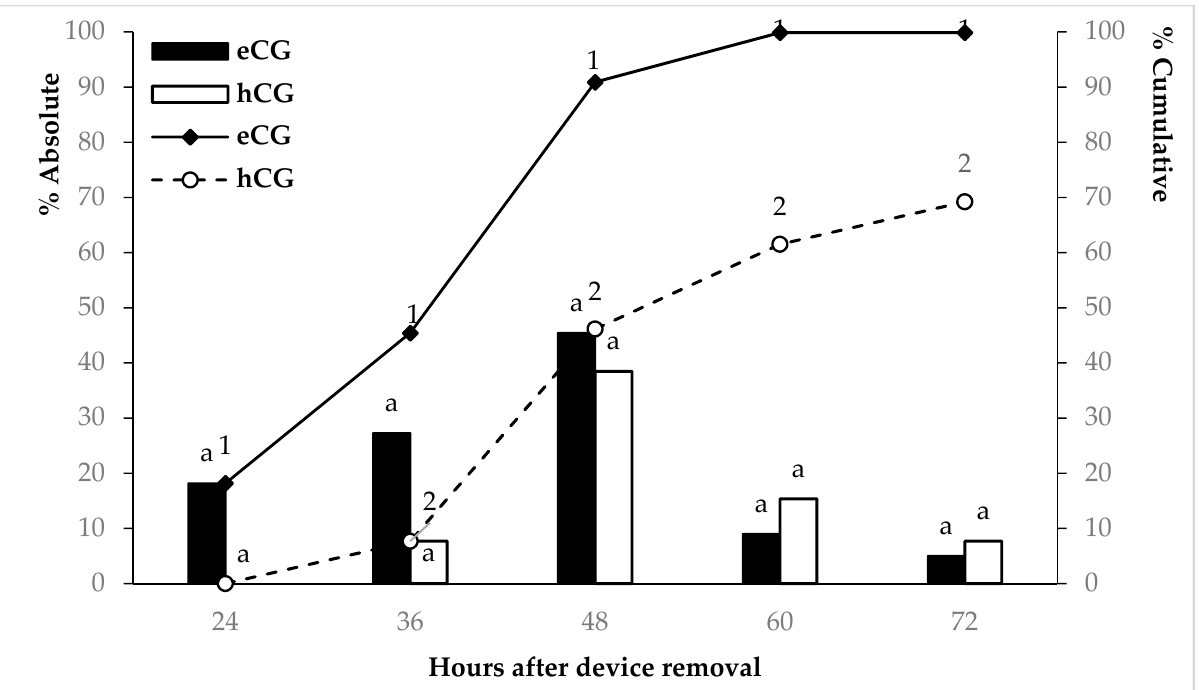
Figure 1. Absolute (bars) and cumulative (lines) percentages of Dorper sheep showing estrus signs over time after CIDR removal and administration of 300 IU of eCG or hCG (Groups eCG and hCG). a Different superscripts indicate significant differences in bars ( p < 0.05); 1, 2 Different numbers indicate significant differences in lines ( p < 0.05).